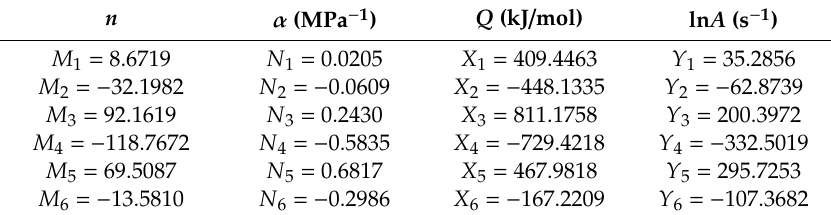
Table 2. Values of material constants of the constitutive